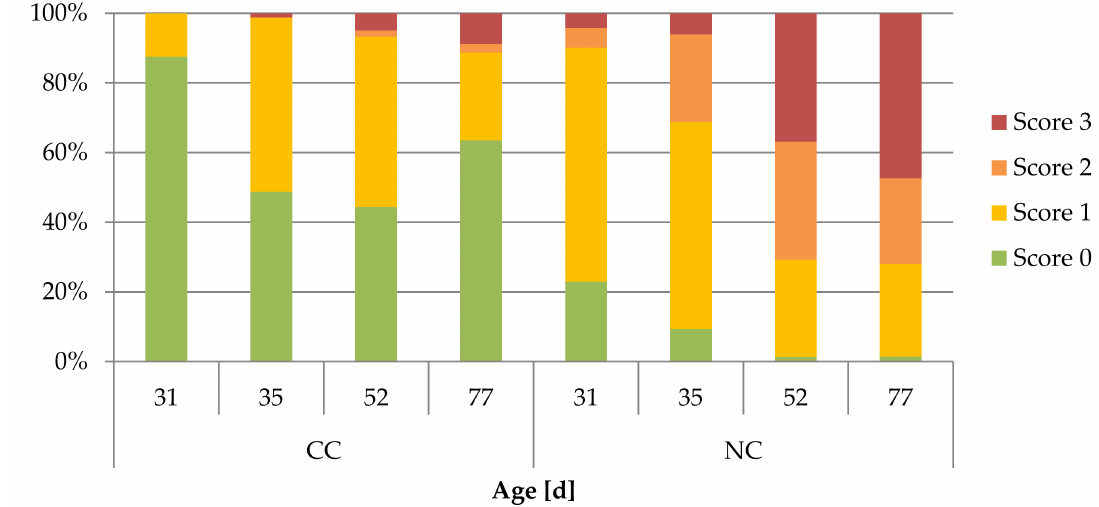
Figure 4. Distribution of rabbits’ hind feet soiling assessed with scores 0–3 (Table 1) under conventional (CC) and new housing conditions